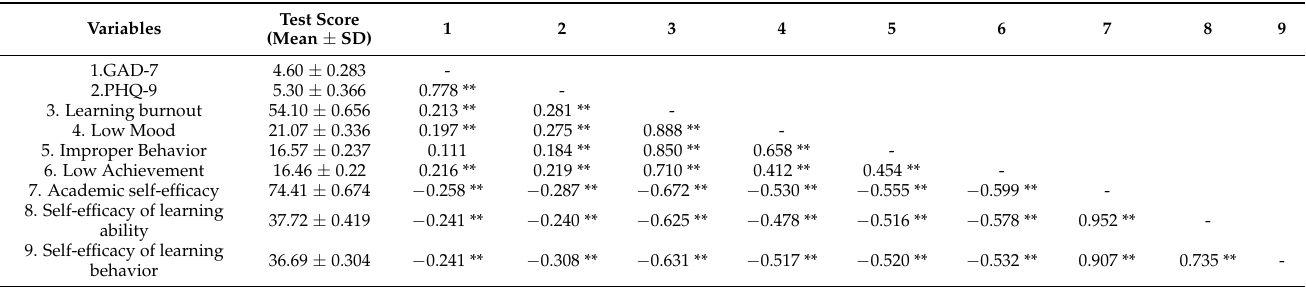
Table 2. Means, standard deviations, and correlations of all the measures ( n = 227).